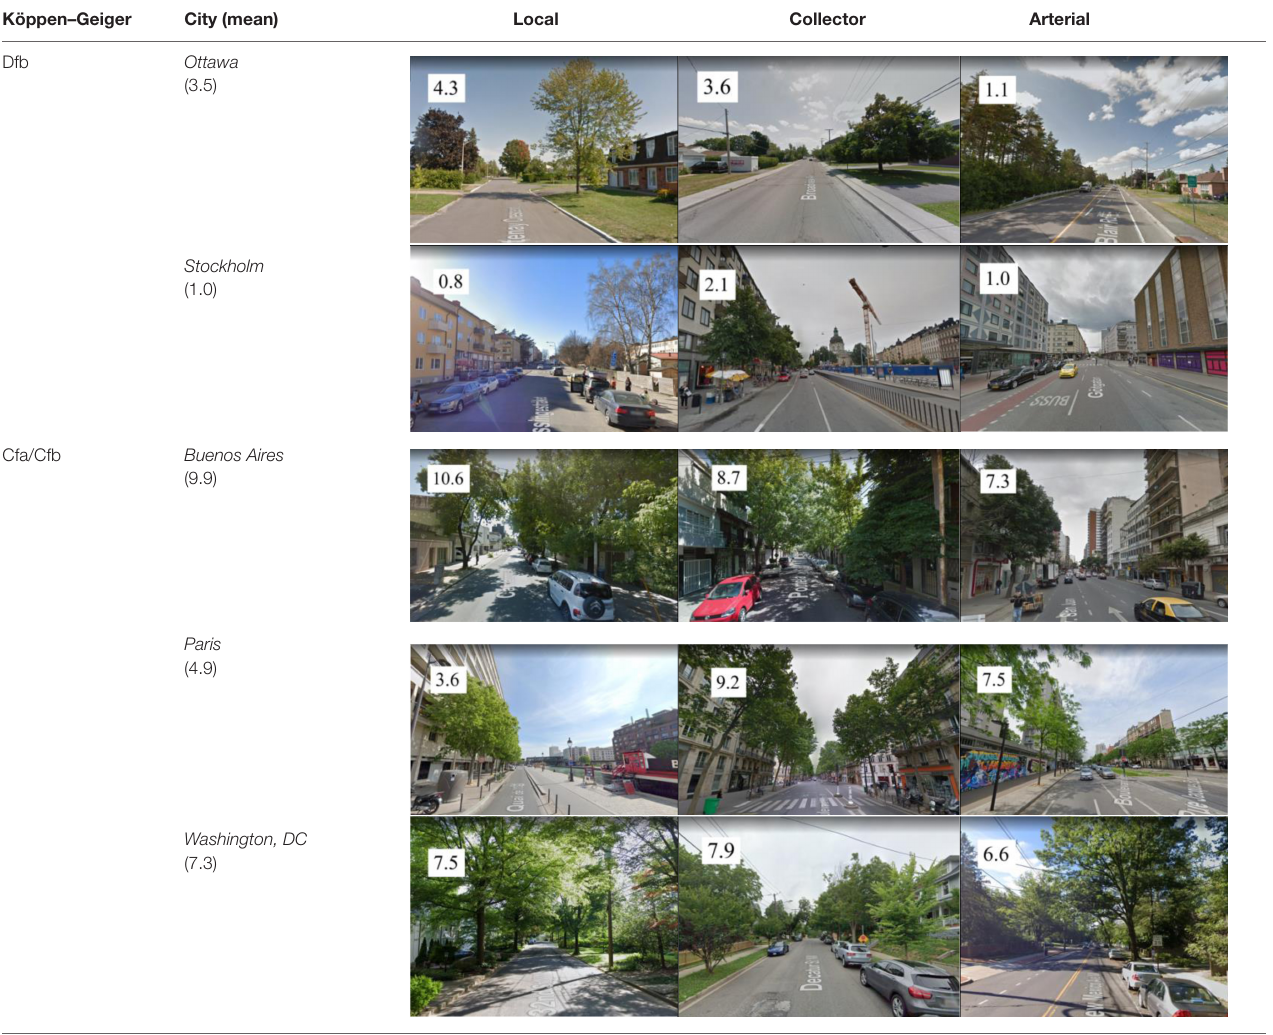
TABLE 3 | Typical street view depiction for street tree density (trees per 100m) by street